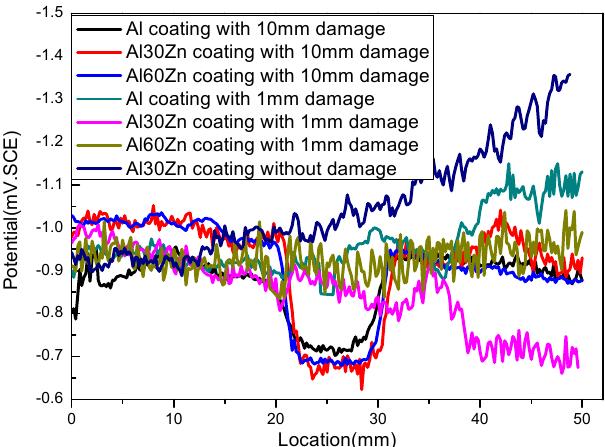
Figure 9. The potential distribution of the different cold ‐ sprayed AlZn coatings with different damaged areas after 2 h immersion collected by scan Kelvin probe (SKP) data (calibrated by SCE).